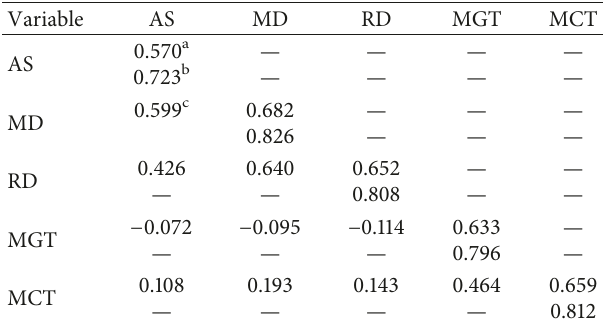
Table 4: Discriminant validity. Variable AS